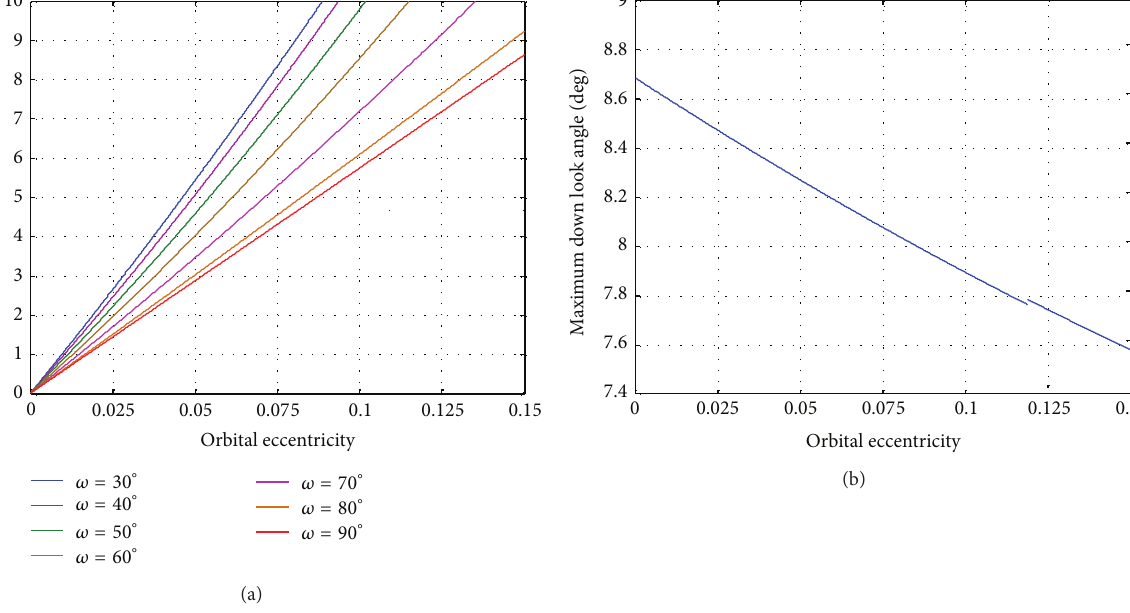
Figure 7: Relationship between the range of the look angle and the orbit parameters. (a) Minimum look angle variation with the eccentricity at different arguments of perigee; (b) Maximum look angle variation with the